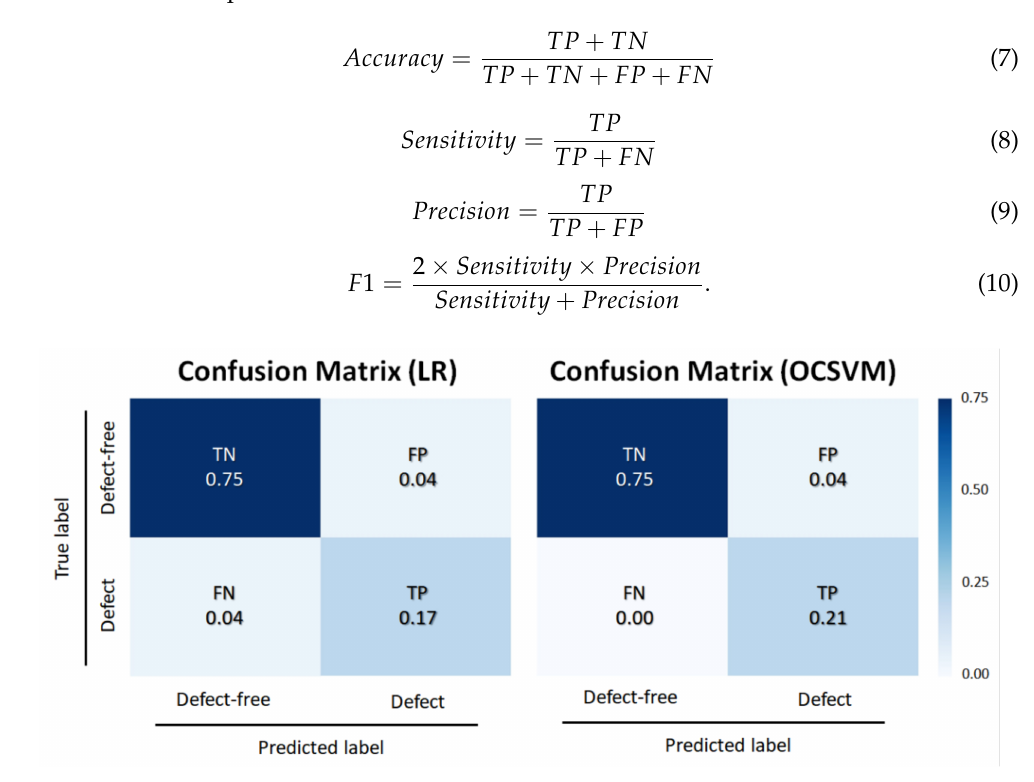
Figure 7. Confusion matrix for a binary classification. The diagonal elements mean the data were classified correctly. Table 1. Performance comparison between LR and OCSVM